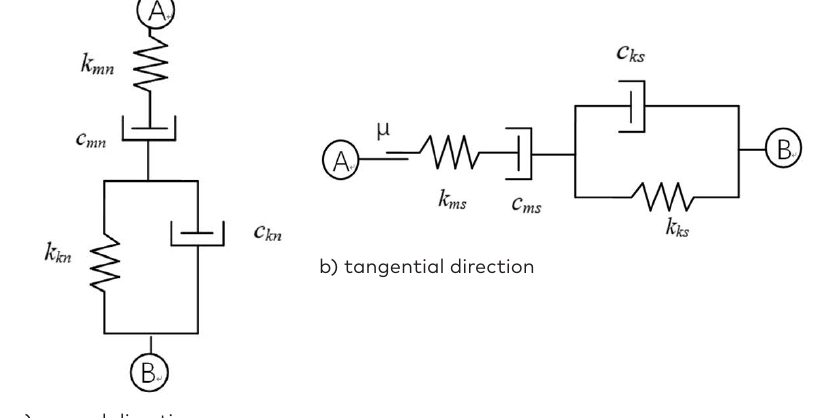
a) normal direction Figure 2. Contacts between asphalt mortar sphere-particles of the Burger model